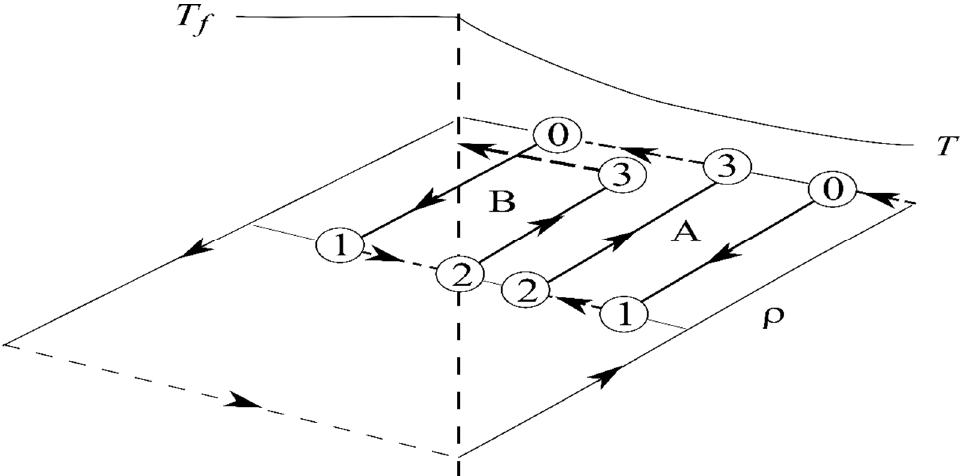
Figure 7. Same as Figure 5, but for DO cycles (thick lines) encased within the H cycle (thin outer lines). Type-A’s stadials remain above the freezing point while type-B’s stadials have reached the freezing point to resemble a mini-H cycle.